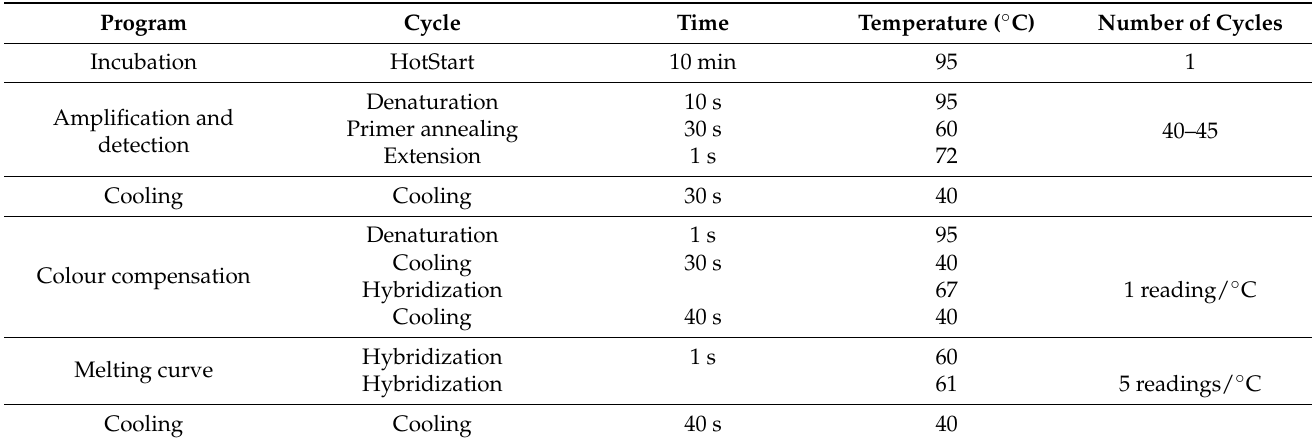
Table 1. PCR reaction parameters with TaqMan